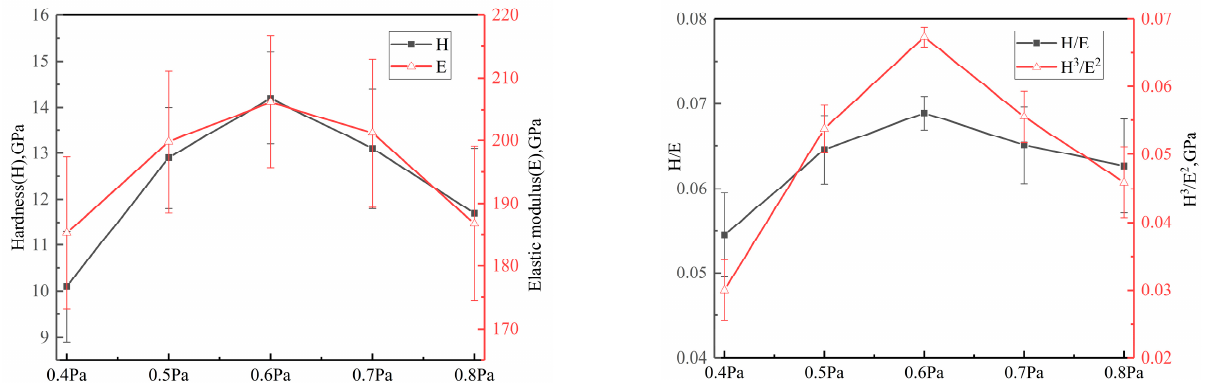
Figure 4. ( Left ) Nanohardness ( H ) and elastic modulus ( E ) and ( right ) H / E and H 3 / E 2 ratios of the CrAgCeN coatings as functions of pressure.